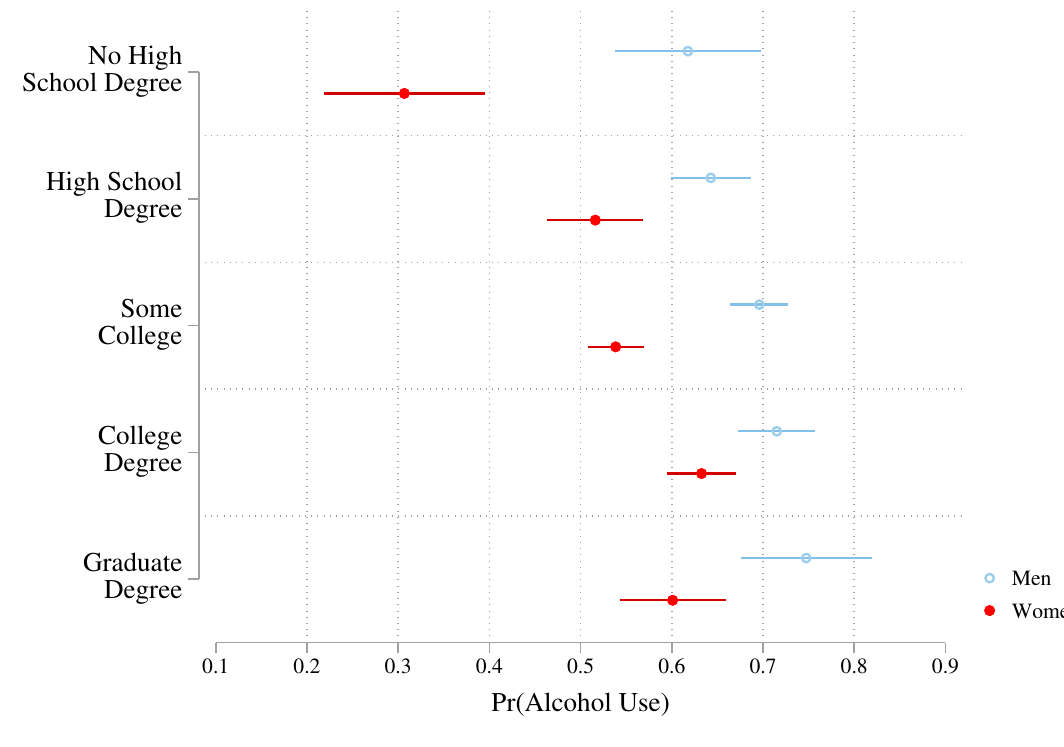
Figure 13: Probability of alcohol use by gender and educational